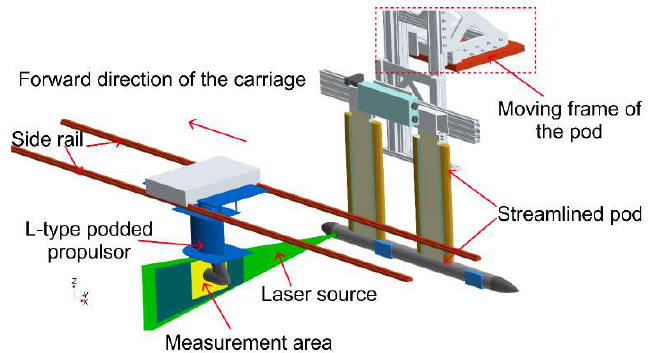
Water 2019 , 11 , x FOR PEER REVIEW Figure 4. Schematic of the flow-field measurement for the L-type podded propulsor.